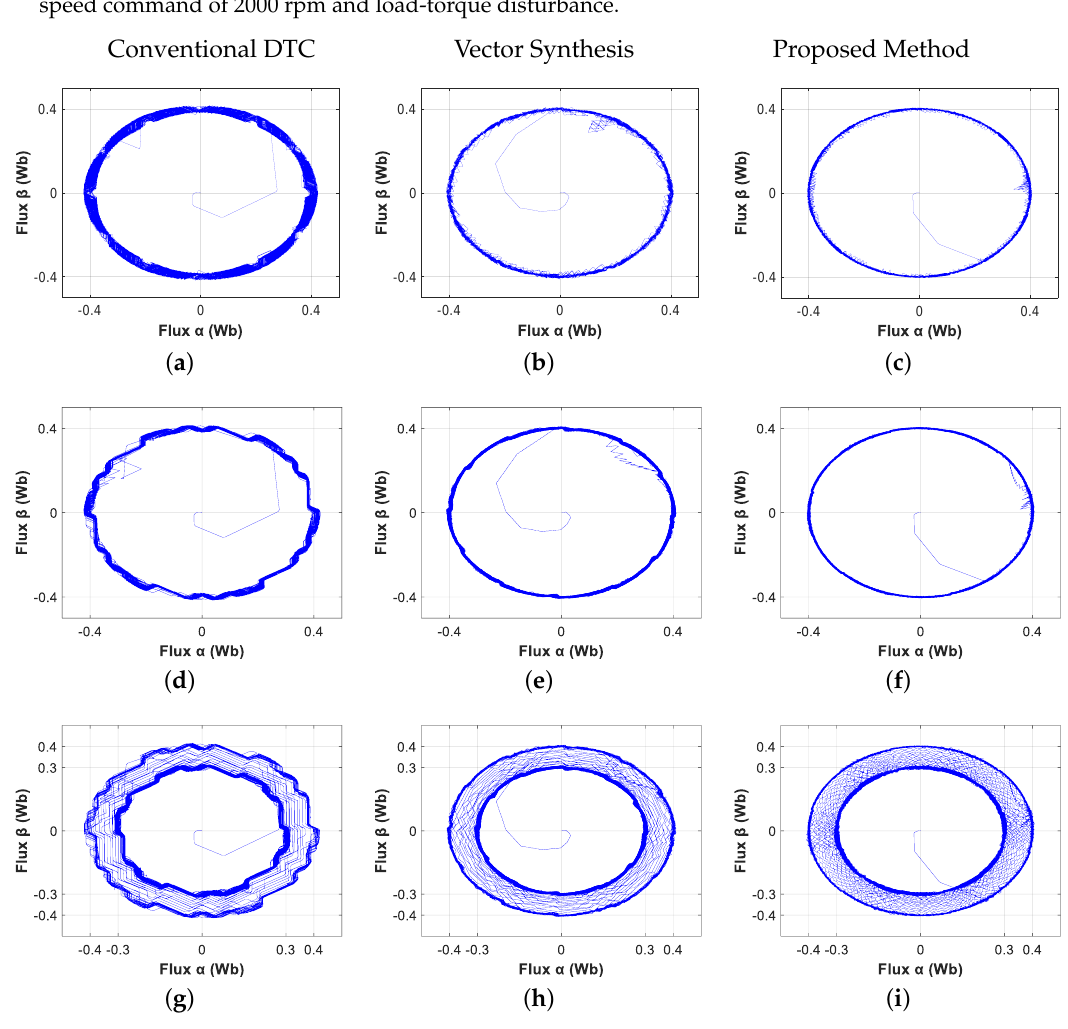
Figure 12. Stator flux trajectories in αβ axes for ( a – c ) 20 rpm, ( d – f ) 1000 rpm, ( g – i ) 2000 rpm (with flux